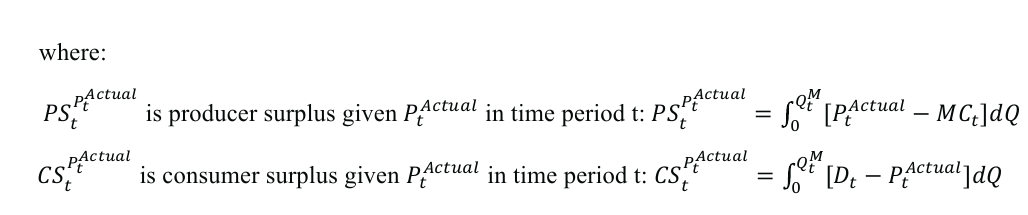
Consumer surplus